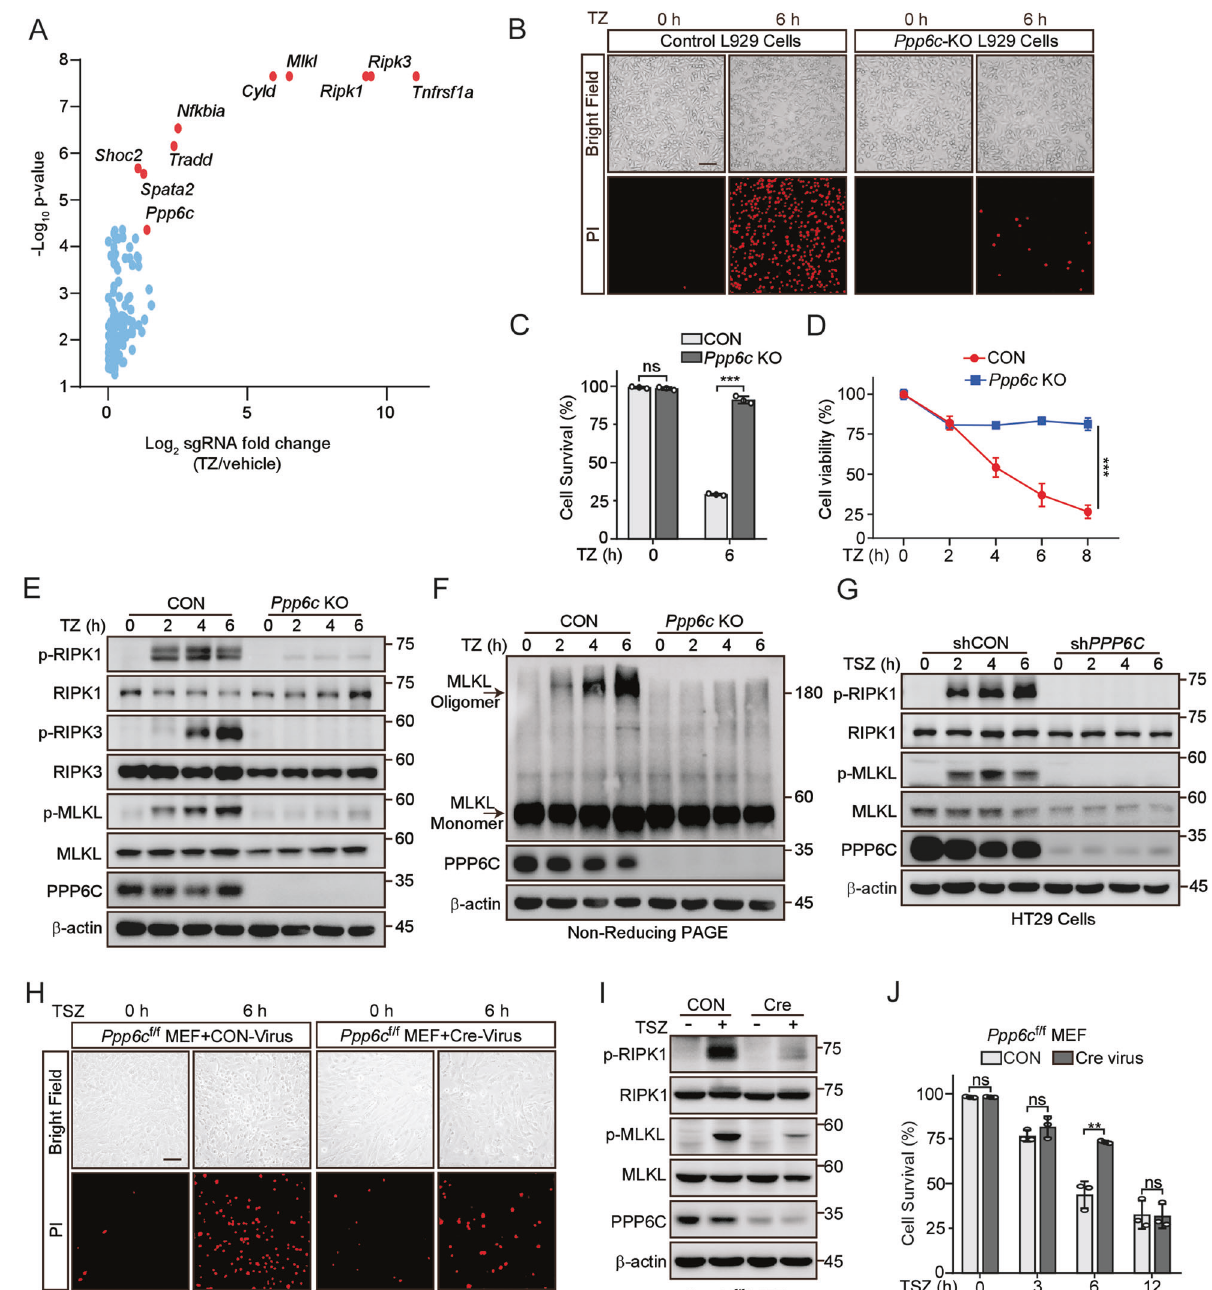
Fig. 1 Deletion of Ppp6c prevents TNF-induced necroptosis. A Scatter diagram revealed that sgRNAs targeting Ppp6c were selected during TNF + Z-VAD-FMK (TZ) treatment in L929 cells. B , C Control and Ppp6c -KO L929 cells were treated with TZ for 6 h and analyzed by propidium iodide (PI) staining under a microscope ( B ) or quanti fi ed by fl ow cytometer ( C ). Scale bar, 50 μ m. D Control and Ppp6c -KO L929 cells were treated with TZ for the indicated time and the cell viability was measured by CCK8. E Control and Ppp6c -KO L929 cells were treated with TZ for the indicated time and the activation of RIPK1, RIPK3 and MLKL proteins was monitored by immunoblot. F Control and Ppp6c -KO L929 cells were treated with TZ for the indicated time and cell lysates were resolved on non-reducing PAGE for immunoblot. G Control and PPP6C - knockdown HT29 cells were treated with TSZ for the indicated time and cell lysates were probed with indicated antibodies. H – J Immortalized Ppp6c f/f MEF cells were infected with control lentivirus or Cre-Lentivirus for 72 h and followed by the treatment with TSZ for 6 h. Cells were stained with PI and analyzed under a microscope ( H ) or lysed for immunoblot with indicated antibodies ( I ), or quanti fi ed by fl ow cytometer after PI staining ( J ). Scale bar, 50 μ m. Data shown are representative of three independent experiments and presented as means ± SDs of triplicates ( C , D , J ). ** p < 0.01, *** p < 0.001, with an unpaired Student ’ s t -test ( C , D , J ). cells but had little effect on Ppp6c -KO L929 cells (Fig. 3A, B, Fig. S3F). Intriguingly, TAK1 inhibitor 5Z-7-Oxozeaenol [47] or IKK α / β with TZ. We found that blocking NF- κ B pathway by two different inhibitor IKK16 [48] completely abolished the resistance of Ppp6c - inhibitors, maslinic acid (targeting P65) [45] and BAY 11-7082 KO cells to TZ-induced necroptosis (Fig. 3C, D, Fig. S3G). Co- (targeting I κ B α ) [46], signi fi cantly increased cell death in control Cell Death and Disease (2022)